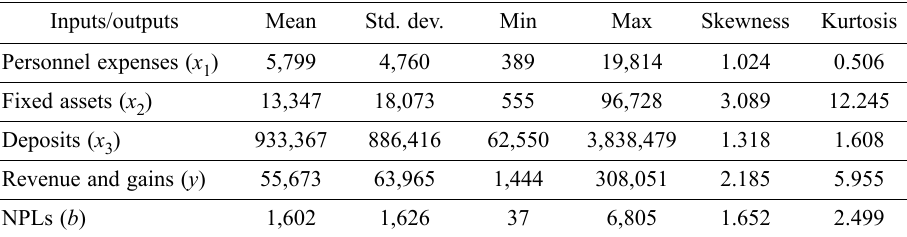
Table 1. Descriptive statistics of inputs and